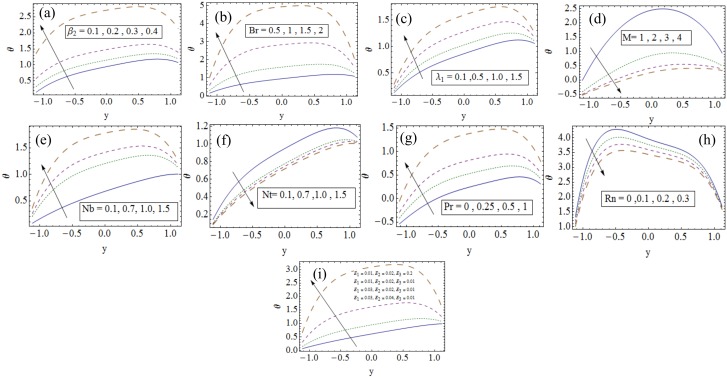
Influences of different parameters on temperature profile when (a). x = ϵ = 0.2, t = 0.1, Rn = 1, Gr = 1, Qr = 0.3, λ1 = 1, Br = 0.5, Pr = 1, Nt = Nb = 0.1, M = 0.2, β1 = β3 = 0.1, E1 = E3 = 0.01, E2 = 0.02. (b). x = ϵ = 0.2, t = 0.1, λ1 = 0.3, Rn = 1, Gr = 1.5, Qr = 1, Pr = 1, Nt = Nb = 0.1, M = 0.2, β1 = β2 = β3 = 0.1, E1 = E3 = 0.01, E2 = 0.02. (c). x = ϵ = 0.2, t = 0.1, Rn = 1, Gr = 1.5, Qr = 1, Br = 0.5, Pr = 1, Nt = Nb = 0.1, M = 0.2, β1 = β2 = β3 = 0.1, E1 = E3 = 0.01, E2 = 0.02. (d). x = ϵ = 0.2, t = 0.1, Gr = 1, Qr = 1, Rn = 1, Gr = 1.5, Qr = 1, λ1 = 0.3, Br = 0.5, Pr = 1, Nt = Nb = 0.1, M = 0.2, β1 = β3 = 0.1, E1 = E3 = 0.01, E2 = 0.02. (e). x = ϵ = 0.2, t = 0.1, Rn = 1, Gr = 1.5, Qr = 0.3, λ1 = 1, Br = 0.5, Pr = 1, Nt = 0.1, M = 0.5, β1 = β2 = β3 = 0.1, E1 = E3 = 0.01, E2 = 0.02. (f). x = ϵ = 0.2, t = 0.1, Rn = 1, Gr = 1, Qr = 0.3, λ1 = 1, Br = 0.5, Pr = 1, Nb = 0.1, M = 0.2, β1 = β2 = β3 = 0.1, E1 = E3 = 0.01, E2 = 0.02. (g). x = ϵ = 0.2, t = 0.1, Rn = 2, Gr = 1.5, Qr = 0.3, λ1 = 1, Br = 1.7, Nt = 0.1, Nb = 1, M = 0.2, β1 = β2 = β3 = 0.1, E1 = E3 = 0.01, E2 = 0.02. (h). x = ϵ = 0.2, t = 0.1, Gr = 1.5, Qr = 0.3, λ1 = 1, Br = 1.7, Pr = 1, Nt = 3, Nb = 2, M = 0.2, β1 = β2 = β3 = 0.1, E1 = E3 = 0.01, E2 = 0.02. (i). x = ϵ = 0.2, t = 0.1, Gr = 1, Qr = 1, Rn = 1, Gr = 1, Qr = 0.3, λ1 = 1, Br = 0.5, Pr = 1, Nt = Nb = 0.1, M = 0.2, β1 = β2 = β3 = 0.1.